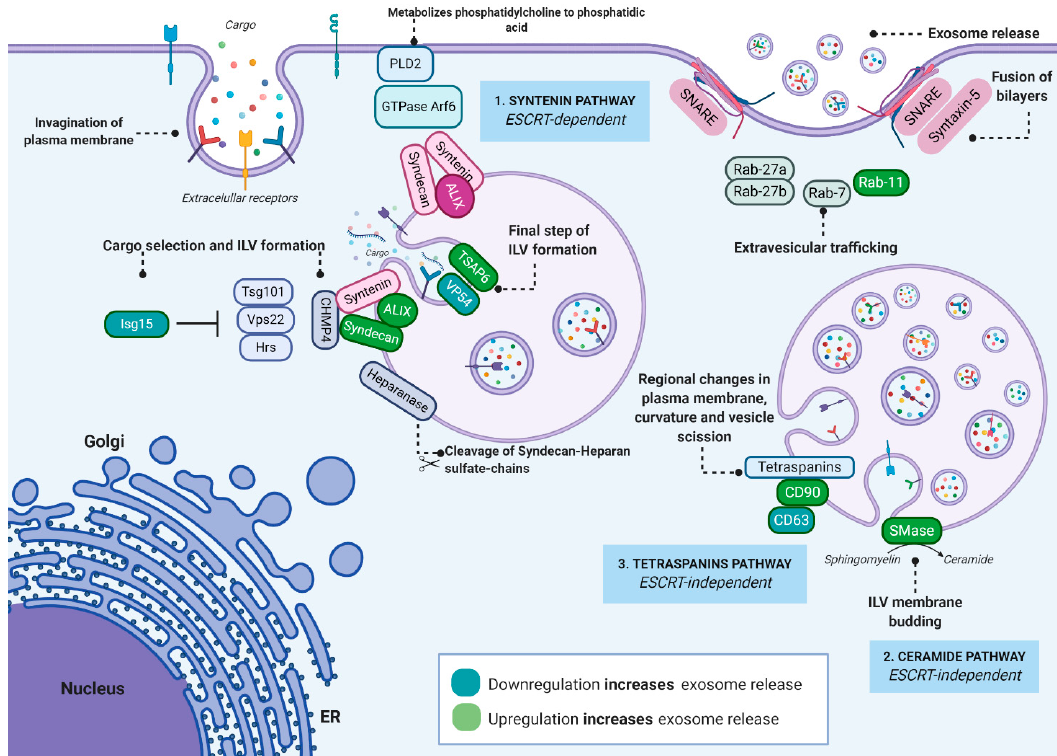
Figure 1. Different exosome biogenesis pathways. Exosome formation begins with syntenin-syndecan interactions which require direct interaction between ALIX and CHMP4 proteins. The intervention of two additional components, Tsg 101 (ESCRT-1) and Vps22 (ESCRT-II), has also been reported, although their mode of action remains little understood. Exosome formation is further regulated by heparanase, an enzyme that cleaves syndecan heparan sulfate, while the small GTase Arf6 also plays a crucial role. The small GTPase ADP ribosylation factor 6 (Arf6) and its e ff ector phospholipase D2 (PLD2) regulate the syntenin pathway. The interaction of Arf6 and PLD2 a ff ects exosome formation by controlling